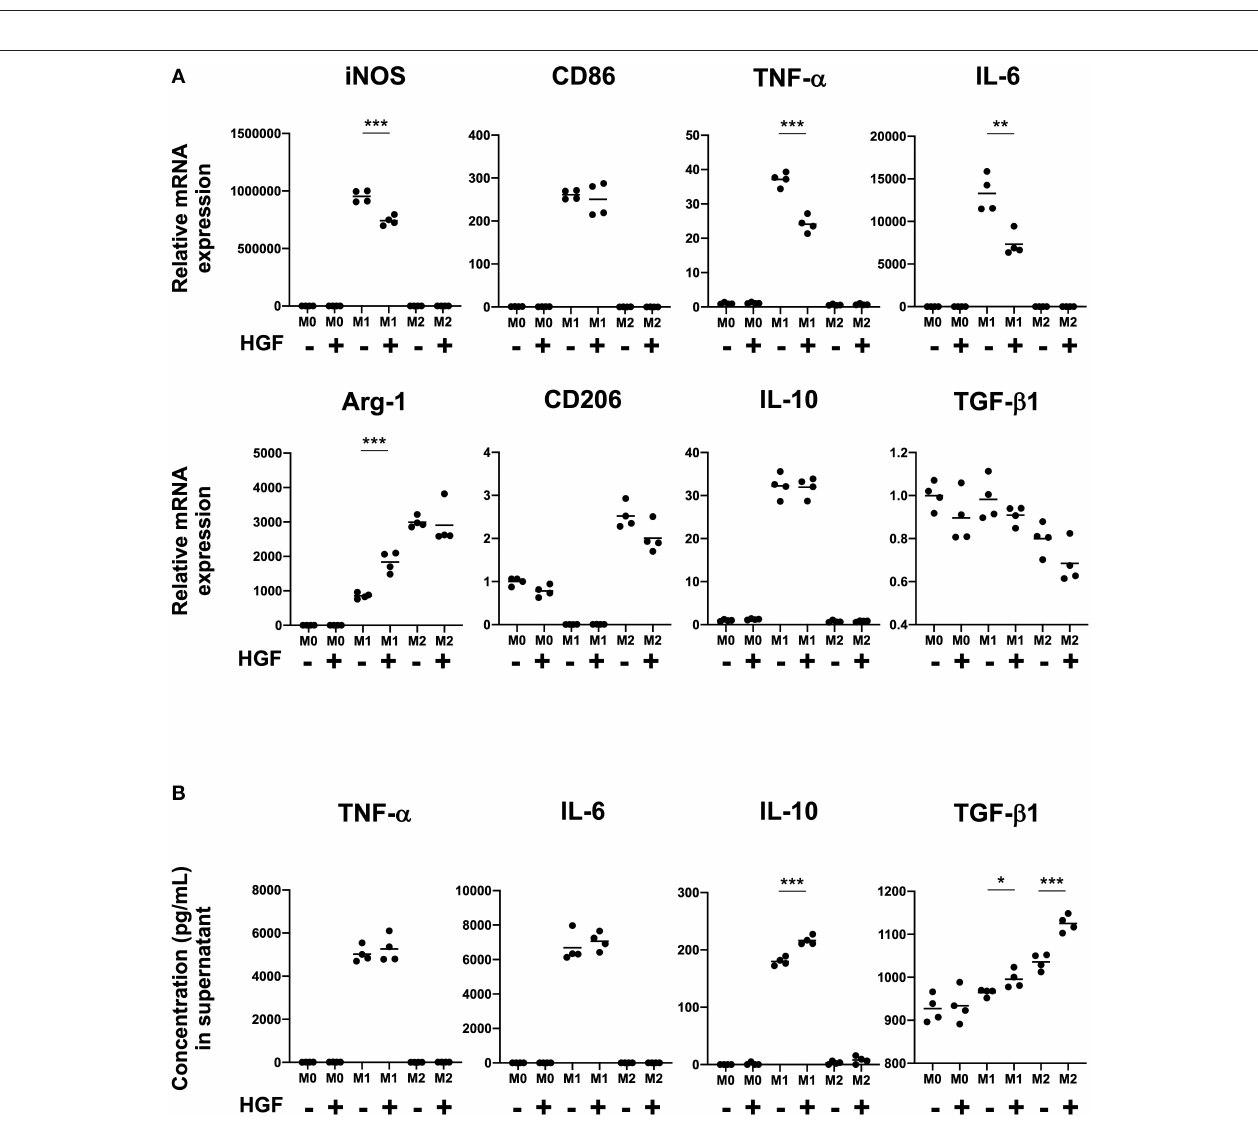
FIGURE 1 | macrophages. (C) Expression of c-Met in M0, M1, and M2 macrophages. c-Met expression was compared using RT-qPCR and western blot. The RT-qPCR Ct values were normalized to those of β -actin and have been expressed relative to mean level in M0, which is arbitrarily defined as 1. β -actin was used as a loading control for western blots. The results are represented as the mean and a scatter plot of individual data points ( n = 4). One-way ANOVA, * P < 0.05 and **** P < 0.0001.